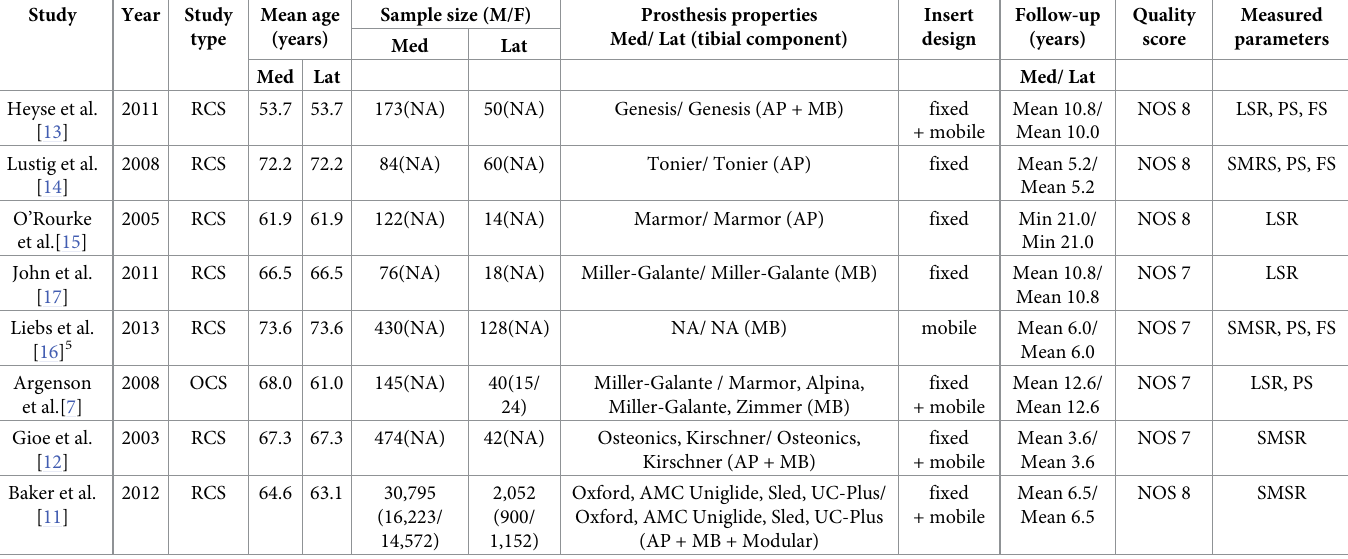
Table 1. Summary of patient characteristics of the included studies.